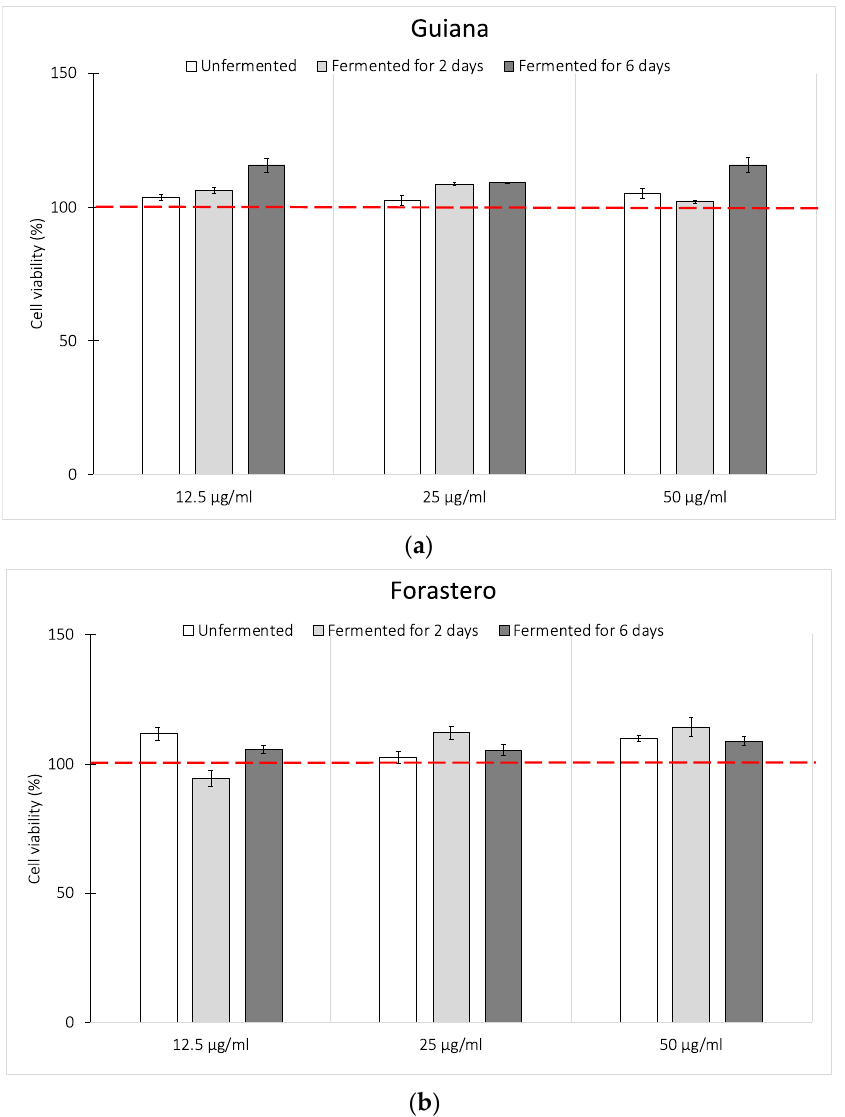
Figure 2. Cell viability of J774A1 macrophages pre-treated for 24 h with various concentrations of Cocoa extract (CE). The cell viability was determined by the 3-(4,5-dimethylthiazol-253 2-yl)-5-(3- carboxymethoxyphenyl)-2-(4-sulfophenyl)-2H-tetrazolium (MTS) and phenazine methosulfate (PMS) assay. ( a ) Guiana, ( b ) Forastero. Results represent the mean viability rate ± SEM ( n = 5).